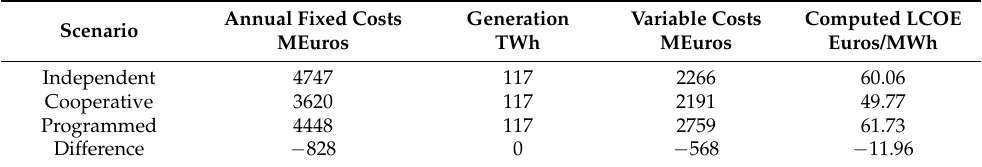
Table 8. Annual expected fixed and variable costs of thermal technologies in the independent, cooperative and programmed scenarios of 2030 and the difference between the cooperative and the programmed